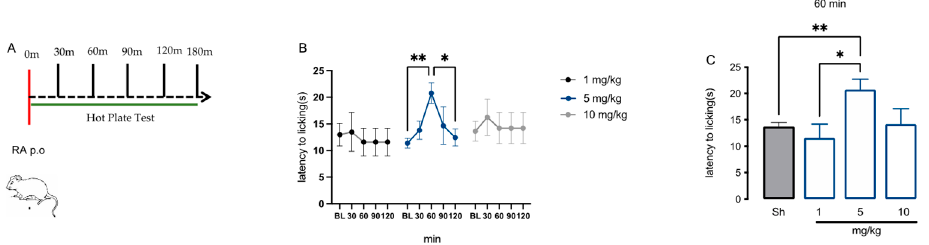
Figure 3. Effect of RA in acute pain. ( A ) Schematic representation of the protocol used in naive mice (Sham, Sh) in the acute pain model ( n = 8 for each experimental group). ( B ) Dose-response curve of orally administered (p.o.) rosmarinic acid (RA) at 30, 60, 90, and 120 min, obtained by hot plate test. Two-way ANOVA ** p < 0.01, * p < 0.05 ( n = 8). ( C ) Comparison of the effect obtained by RA at the dose of 1, 5, and 10 mg/kg at the 60-min peak activity. One-way ANOVA ** p < 0.01, * p < 0.05 ( n = 8).